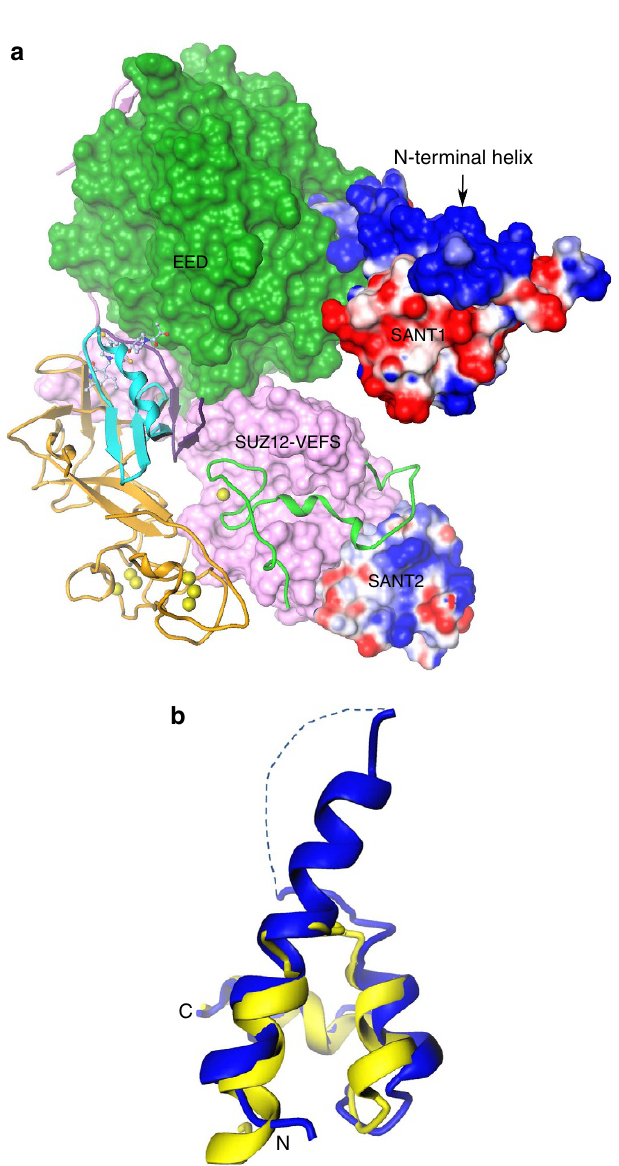
Figure 4 | The SANT domains. ( a ) Hs/Ac PRC2 structure is shown with EZH2 N-terminal helix and the SANT domains in electrostatic surface representation, and EED (green) and SUZ12 (pink) in Connolly surface representation. SANT1 is very acidic and packs against the basic N-terminal helix, while SANT2 is basic in nature. ( b ) Comparison of SANT1 domain (blue) with SANT2 (yellow) domain. Dotted line indicates the dynamic linker between the two N-terminal helices of SANT1. While overall architectures are very similar, SANT1 is larger than